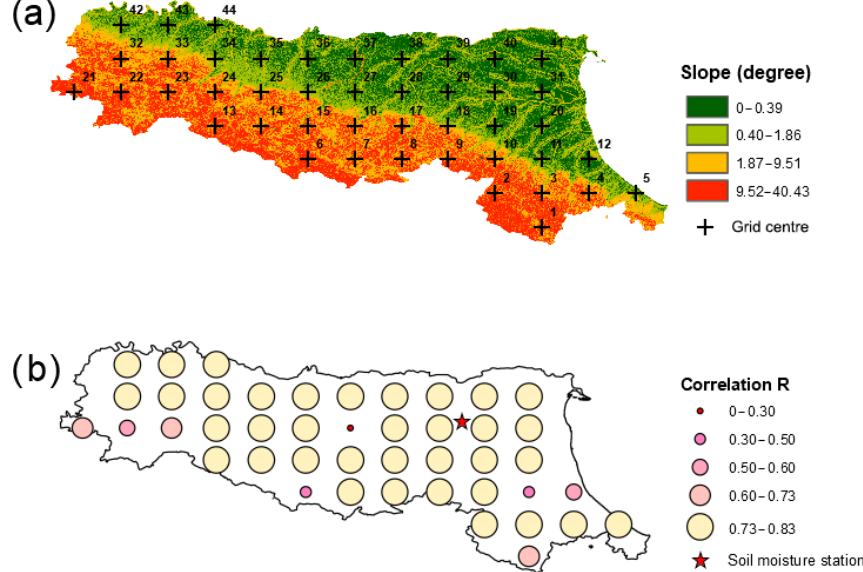
Figure 10. The cross-validation of spatially distributed WRF soil moisture against the in situ soil moisture observation at the single-point soil moisture sensor in a plain area: (a) grid numbers shown on the slope map, (b) correlation spatial performance.